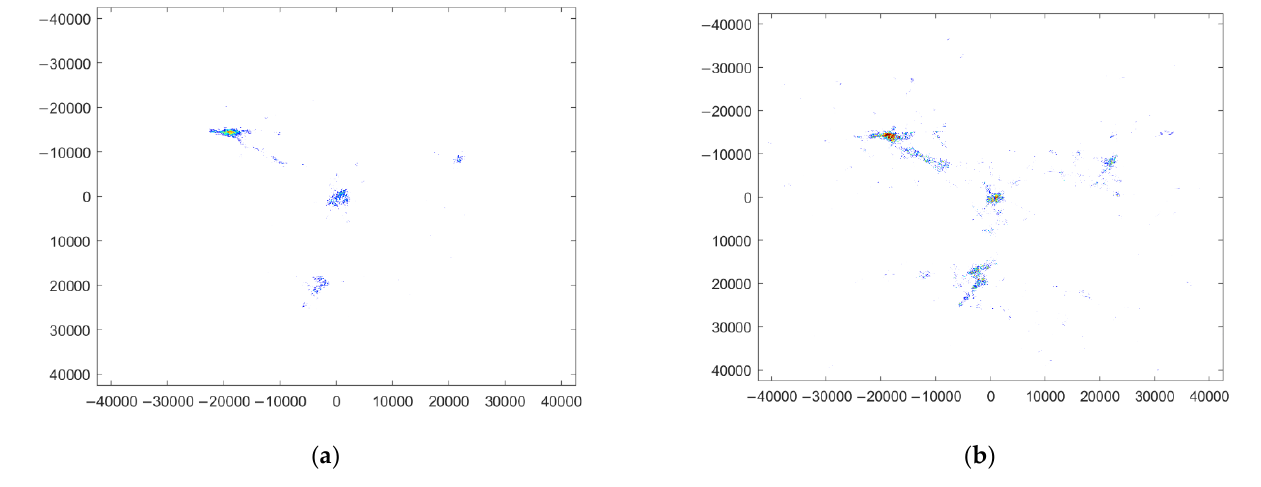
Figure 14. Amplitude estimation results based on inverse Radon transform: ( a ) Amplitude estimation results based on the inverse Radon transform at an SNR of 5 dB. ( b ) Amplitude estimation results based on the inverse Radon transform at an SNR of 0